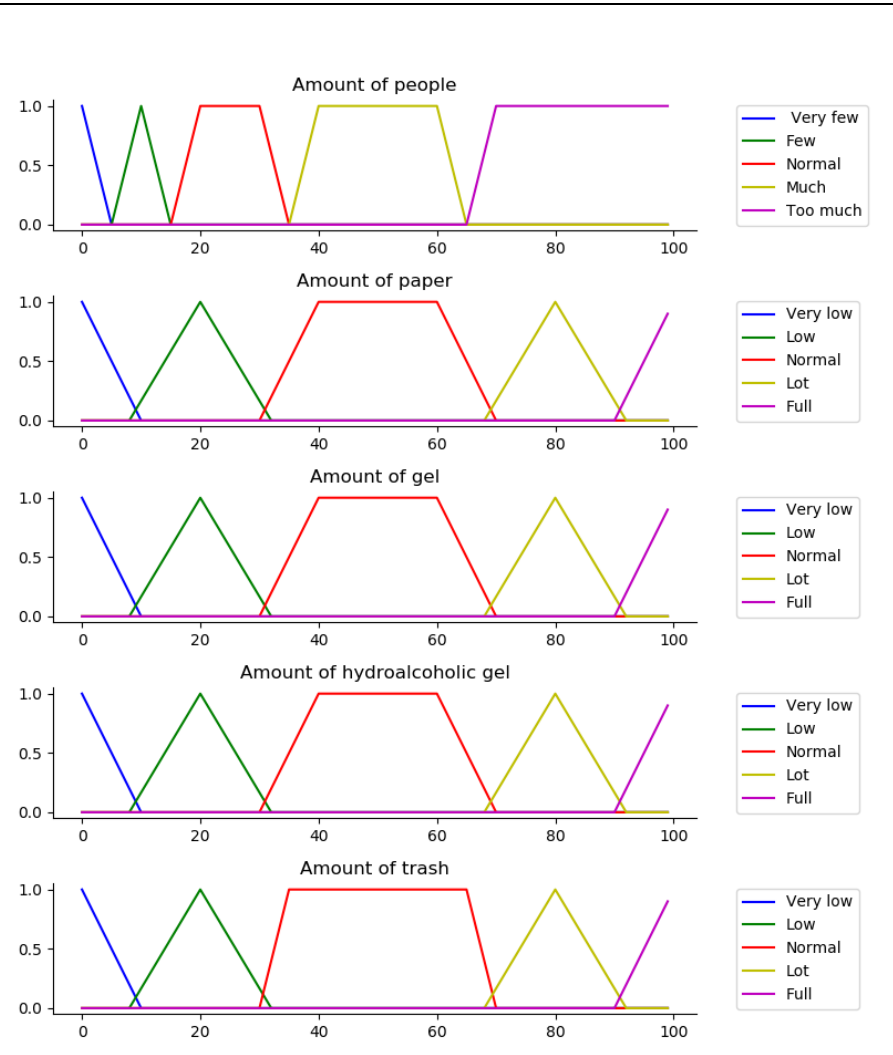
Figure 10. Inputs’ membership